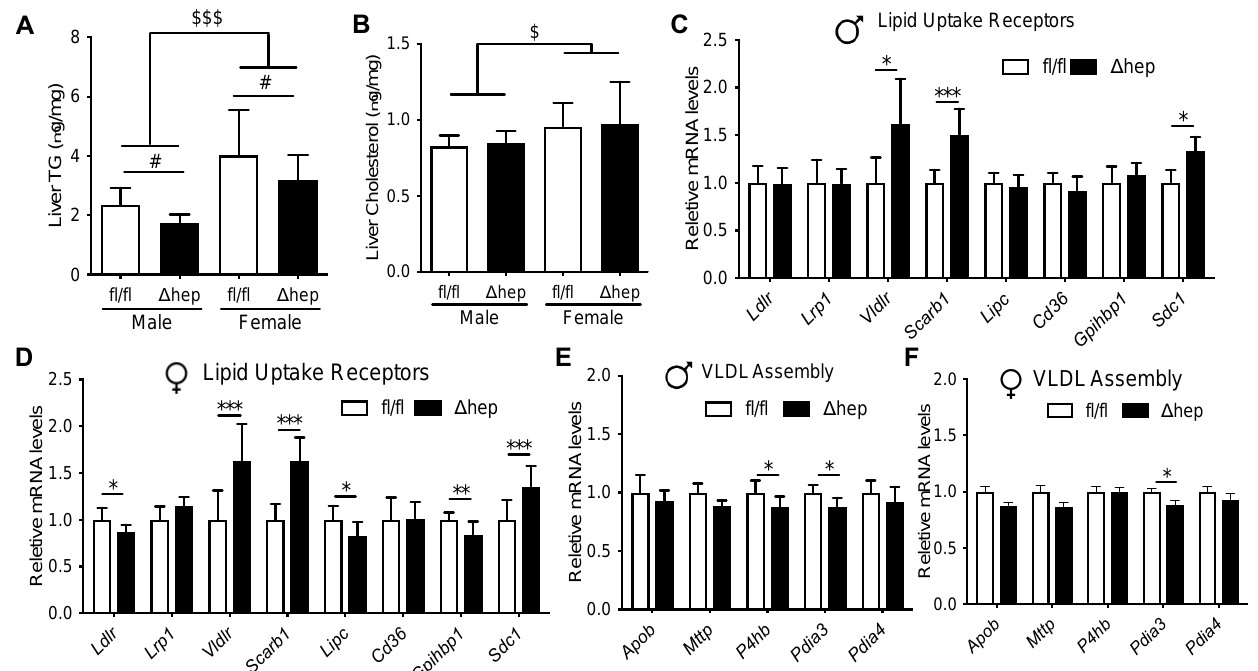
Figure 3. Effect of hepatic deletion of SHP on liver lipid content and metabolism. Ad lib chow fed male and female SHP fl/fl and SHP ∆ hep littermates were used for the study ( n = 7–9/group). ( A , B ) Liver TG ( A ) and cholesterol ( B ) contents. # p < 0.05 for genotype effect. $ p < 0.05, $$$ p < 0.001 for sex effect (2-way ANOVA). ( C , D ) mRNA levels of liver lipid uptake receptors in SHP fl/fl and SHP ∆ hep males ( C ) and females ( D ). ( E , F ) mRNA expression of VLDL production and assembly genes in males ( E ) and females ( F ). * p < 0.05, ** p < 0.01, *** p < 0.001, ( t -test).